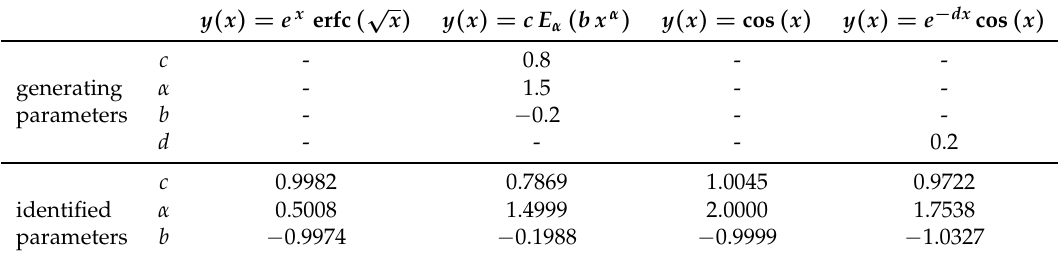
Figure 2. Mittag-Leffler fitting using different functions y ( x ) for generating data [57]. Table 1. Identified parameters of the Mittag-Leffler fitting model: y ( x ) = c E α ( b x α )